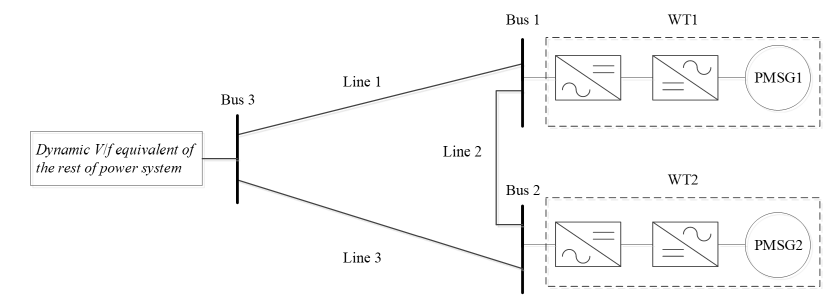
Figure 7. The benchmark to test the control strategies.